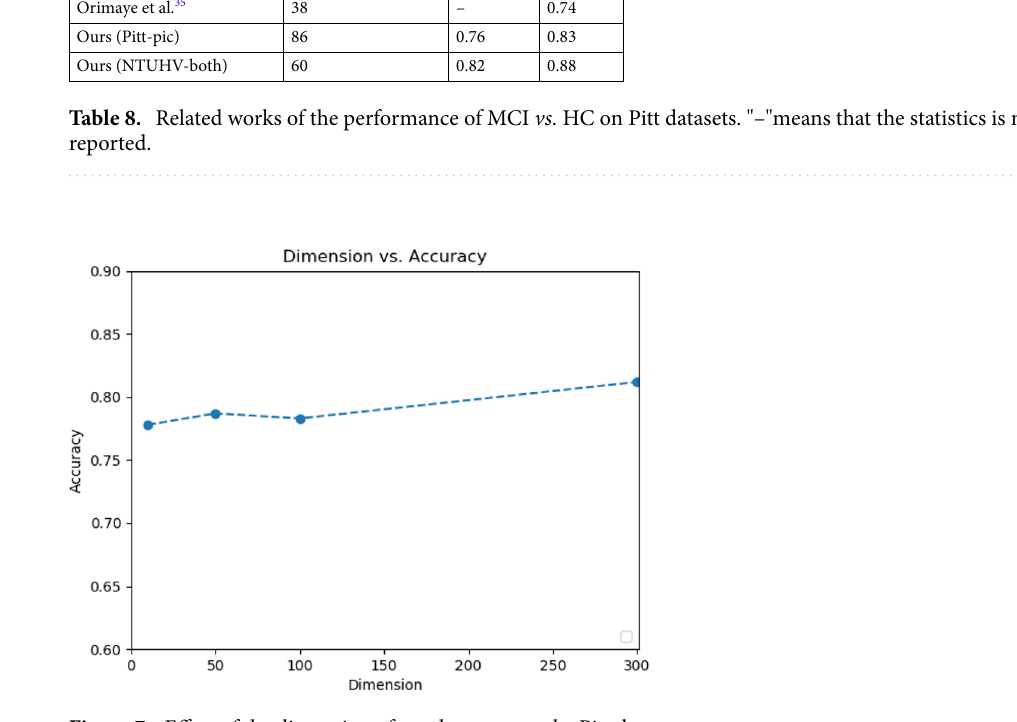
Figure 7. Effect of the dimension of word vectors on the Pitt dataset.